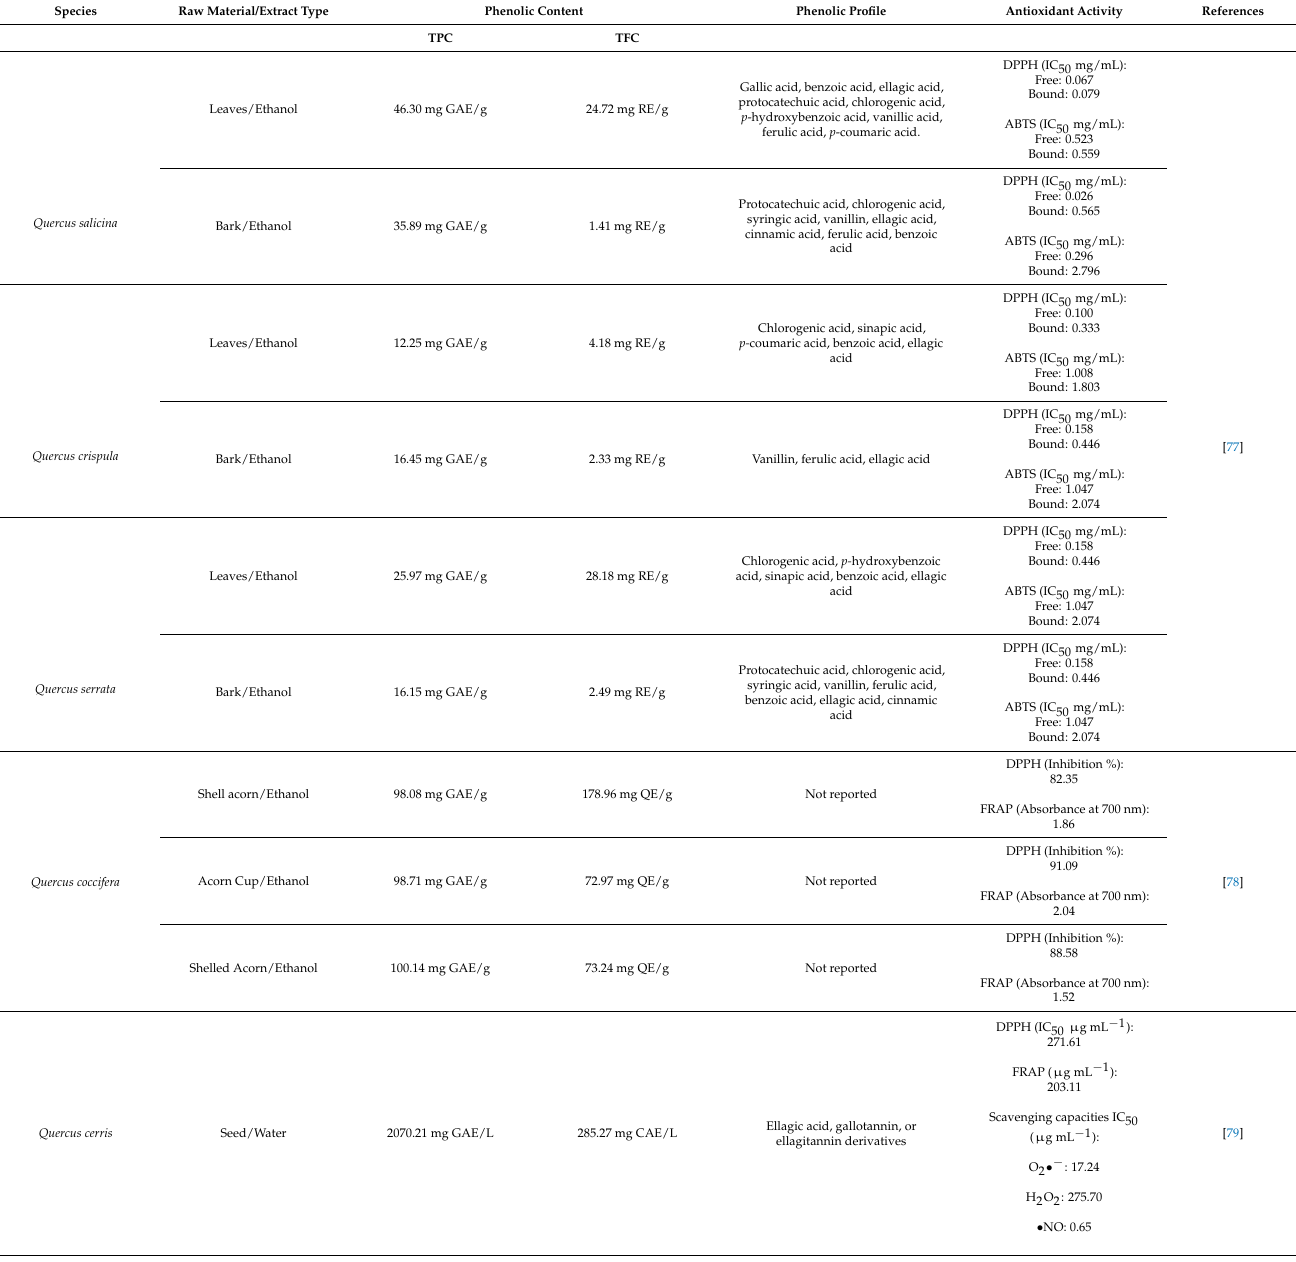
Table 2. Phenolic content, identified compounds, and antioxidant activity of various reported Quercus